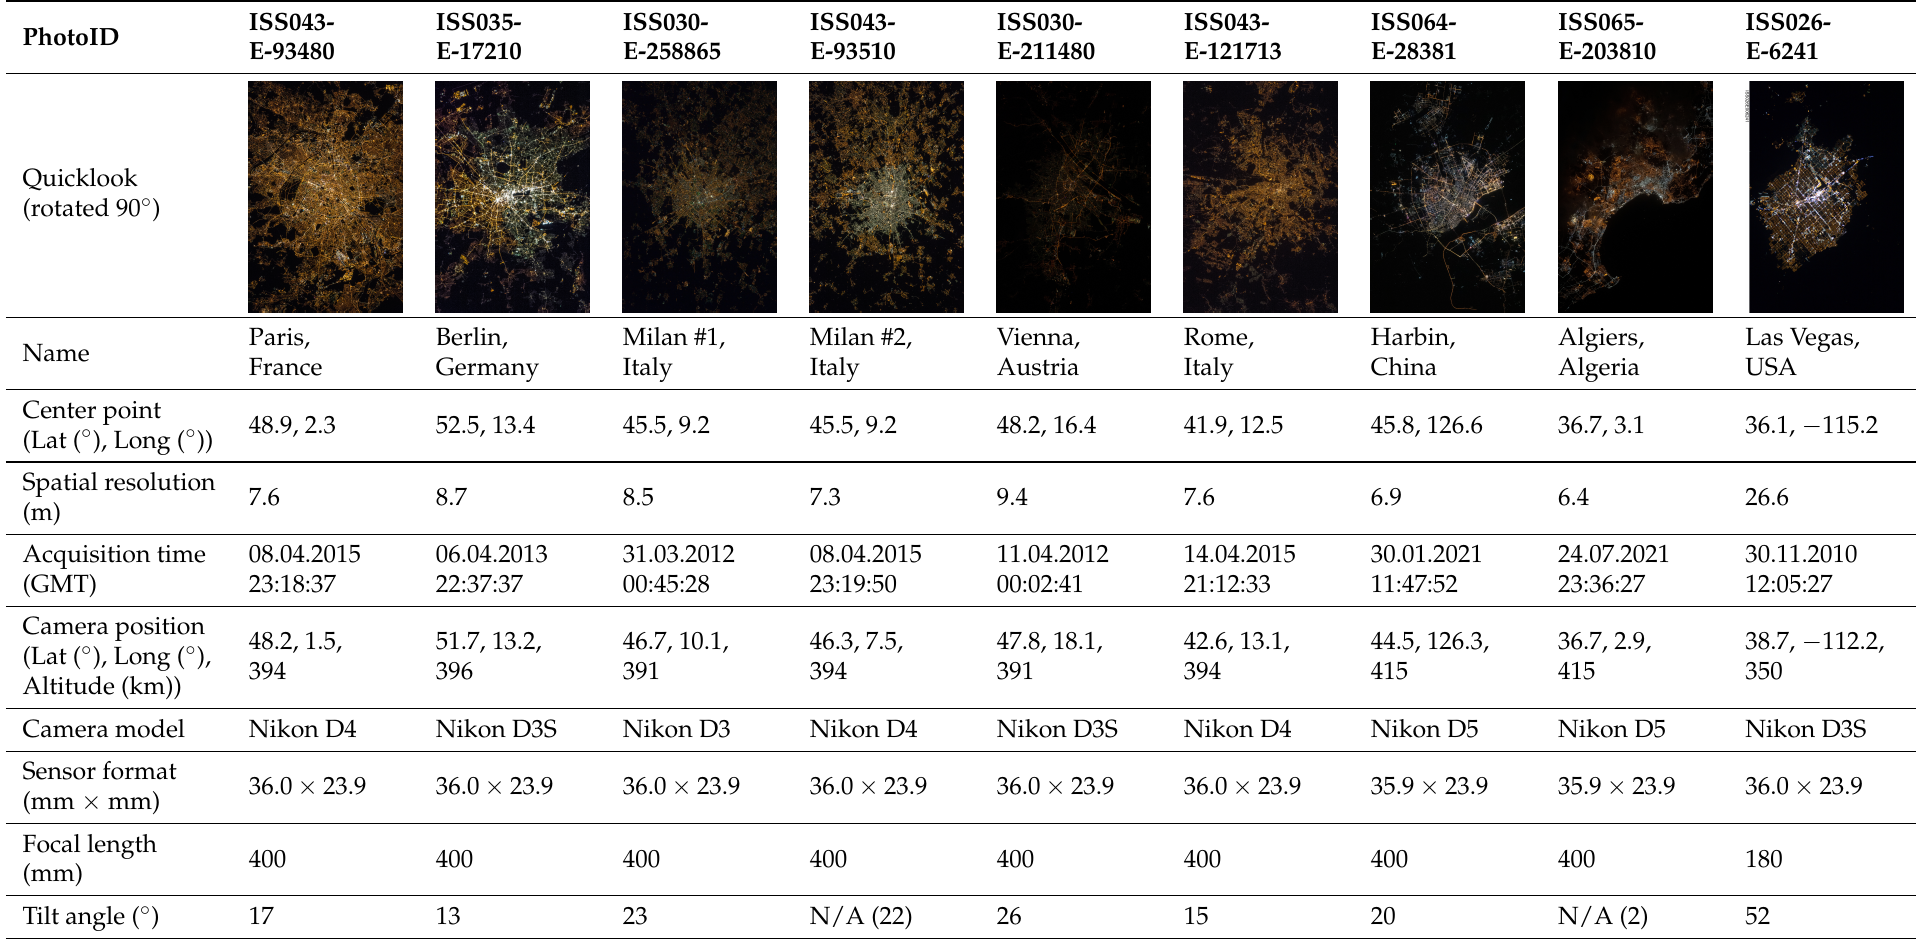
Table 1. Details of the NTL imagery used for